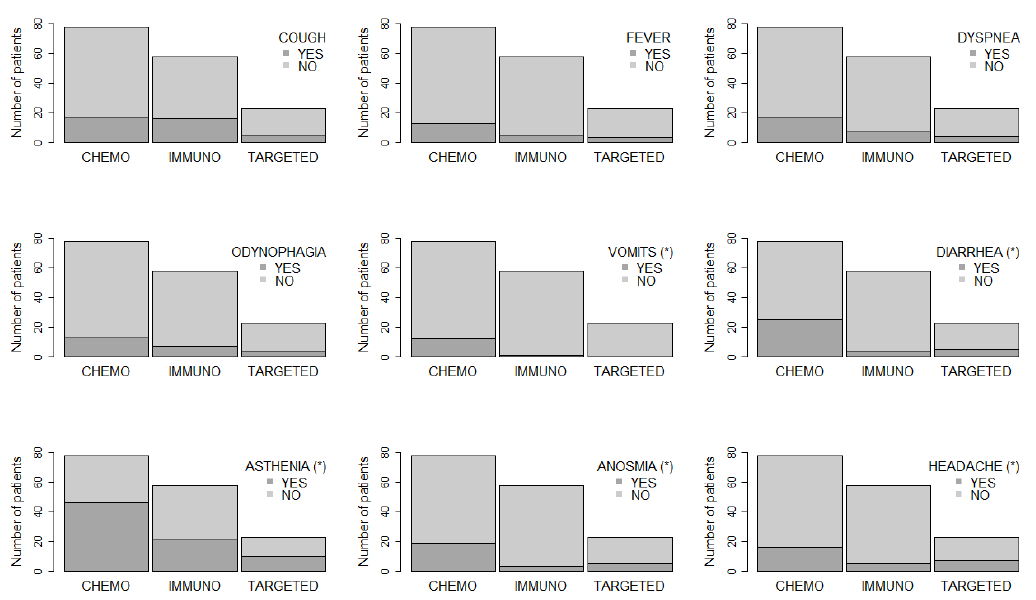
Figure 1. Relationship between the type of treatment and the presence or absence of symptoms. A star (*) means that there is a statistically significant association according to Fisher’s exact test [9] (sig. level = 0.05).